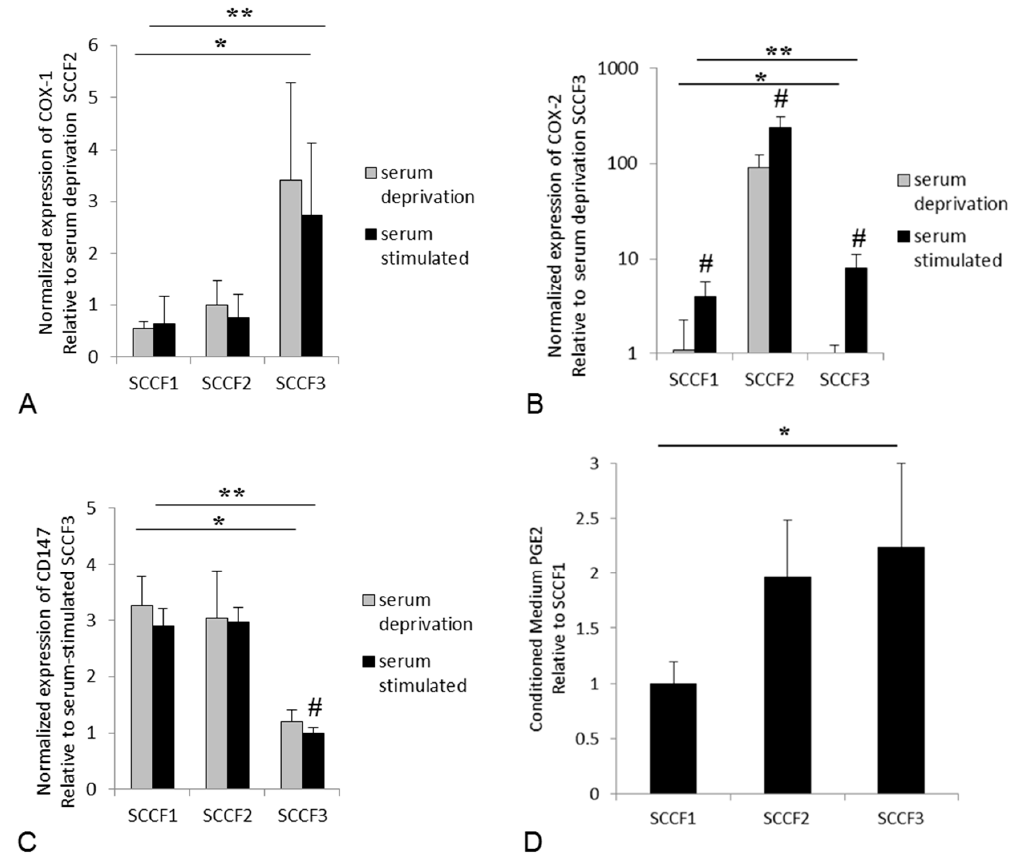
Figure 4. COX-1, COX-2, and CD147 mRNA expression, and prostaglandin E2 (PGE2) secretion from feline OSCC cell lines in vitro. ( A ) Each bar represents the mean fold increase in COX-1 mRNA compared to serum-deprived SCCF2 cells. There was no significant effect of serum exposure on COX-1 expression. The expression of COX-1 differed between the three cell lines in serum deprived (*) and stimulated (**) conditions, with SCCF3 expressing the most COX-1, and SCCF1 cells expressing the least COX-1. ( B ) Each bar represents the mean fold increase in COX-2 mRNA compared to serum-deprived SCCF3 cells. Serum exposure significantly stimulated COX-2 expression in all three cell lines. The expression of COX-2 differed between the three cell lines in serum-deprived (*) and stimulated (**) conditions, with SCCF2 cells expressing the most, and SCCF1 cells expressing the least. ( C ) Each bar represents the mean fold increase in CD147 mRNA compared to serum-stimulated SCCF3 cells. Serum exposure only had a significant effect on the SCCF3 expression of CD147. The expression of CD147 differed between the three cell lines in serum-deprived (*) and stimulated (**) conditions, with SCCF3 cells expressing the least CD147. ( D ) Each bar represents the mean PGE2 concentration relative to conditioned medium from SCCF1 cells. SCCF1 cells secreted the least PGE2. The average concentration of PGE2 in SCCF1-conditioned medium was 22.2 pg/mL per 100,000 cells. Each graph represents combined data from three independent experiments. All of the statistical comparisons of RT-qPCR data were made using the Kruskal–Wallis test (* serum-deprived, p value < 0.05; ** serum-stimulated, p value < 0.05; # serum-deprived compared to serum-stimulated, p value < 0.05). PGE2 concentrations were compared using the Kruskal–Wallis test (* p value <